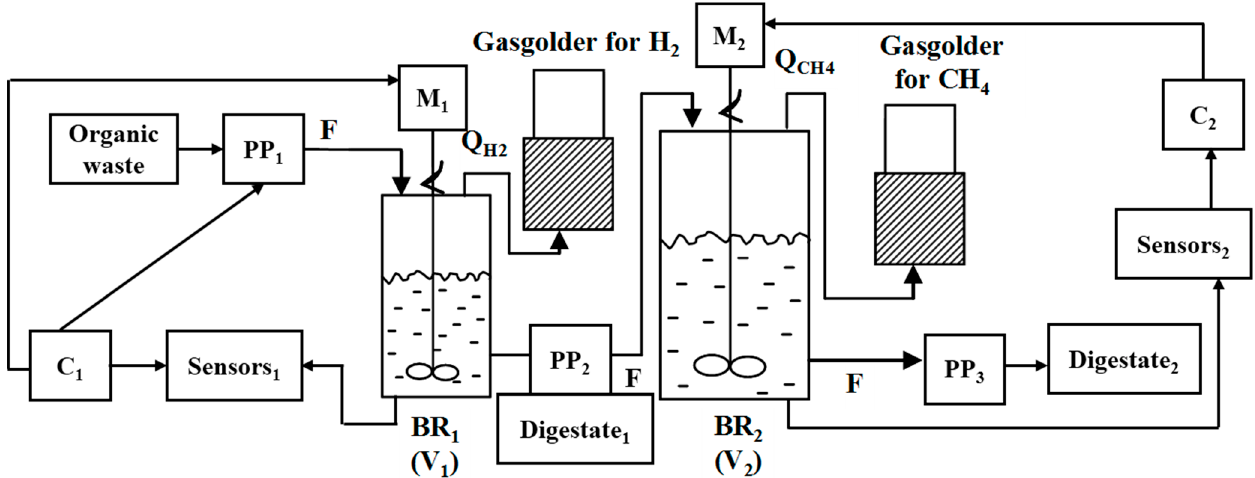
Figure 1. Scheme of the experimental setup. (PP 1 —peristaltic pump for the influent of BR 1 ; PP 2 — peristaltic pump for the effluent of BR 1 and influent of BR 2 ; PP 3 —peristaltic pump for the effluent of